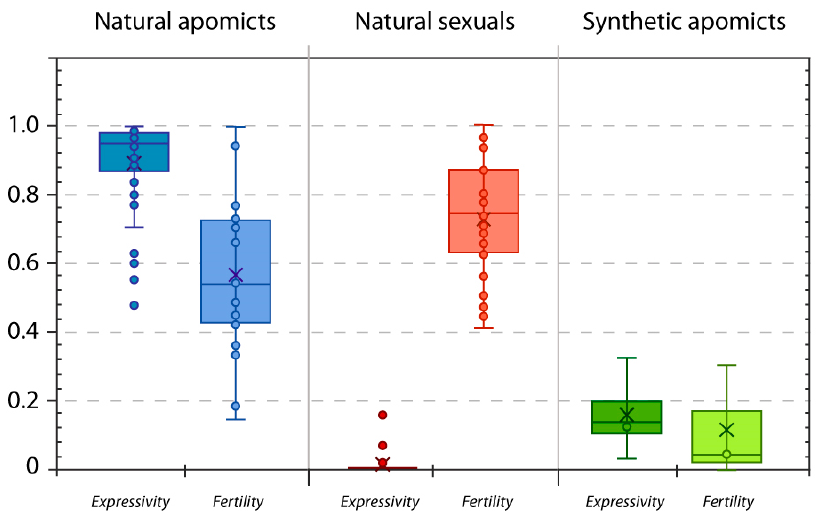
Figure 3. Box and whiskers plot representing observed variability in expressivity and fertility of apomixis in different biological conditions. In natural apomictic genotypes, apomixis expressivity is high ( n = 35; average = 0.89 ± 0.14, max = 1, min = 0.48) and exhibits medium fertility (n = 18; average = 0.57 ± 0.24, max = 1, min = 0,15). In natural sexuals, only traces of apomixis have been recorded in specific cases ( n = 33; average = 0.007 ± 0.027, max = 0.15, min = 0.0) and these plants exhibit high fertility ( n = 35; 0.73 ± 0.17, max = 1, min = 0.41). Synthetic apomicts created so far show very low expressivity ( n = 4; average = 0.16 ± 0.012, max = 0.33, min = 0.03; Table 2) and very low fertility ( n = 3; average = 0.12 ± 0.16, max = 0.3, min = 0.002; Table 2). The graph is based on data from 42 species showing diplosporous and aposporous apomixis, autonomous and pseudogamous seed development, and their sexual conspecific taxa. Because gametophyte frequencies underestimate apomixis expressivity, all data were collected from studies on flow cytometry on seeds developed under open pollination (except for Erigeron in which parthenogenetic development was confirmed through embryology; [151]). Seeds developed through syngamy of meiotic gametes or meiotic plus apomeiotic gametes (i.e., incomplete apomixis and B III hybrids) were classified as sexual. In species where data from multiple genotypes were available, only the mean value was used to avoid sampling bias (e.g., in Paspalum intermedium , n = 18 genotypes, expressivity = 0.86 ± 0.08, fertility = 0.19 ± 0.11; [152]). In some cases, fertility data were missing because of technical constraints (e.g., Hypericum forms several thousand seeds per fruit). Species included belong to the genus Boechera ( n = 8, [153–155]), Boehmeria ( n = 1, [156]), Erigeron ( n = 2, [151]), Hieracium ( n = 10, [157,158]), Hypericum ( n = 1, [159]), Paspalum ( n = 9, [152,160–165]), Pilosella ( n = 2, [166]), Poa ( n = 3, [167]), Ranunculus ( n = 4, [168,169]), Taraxacum ( n = 2,